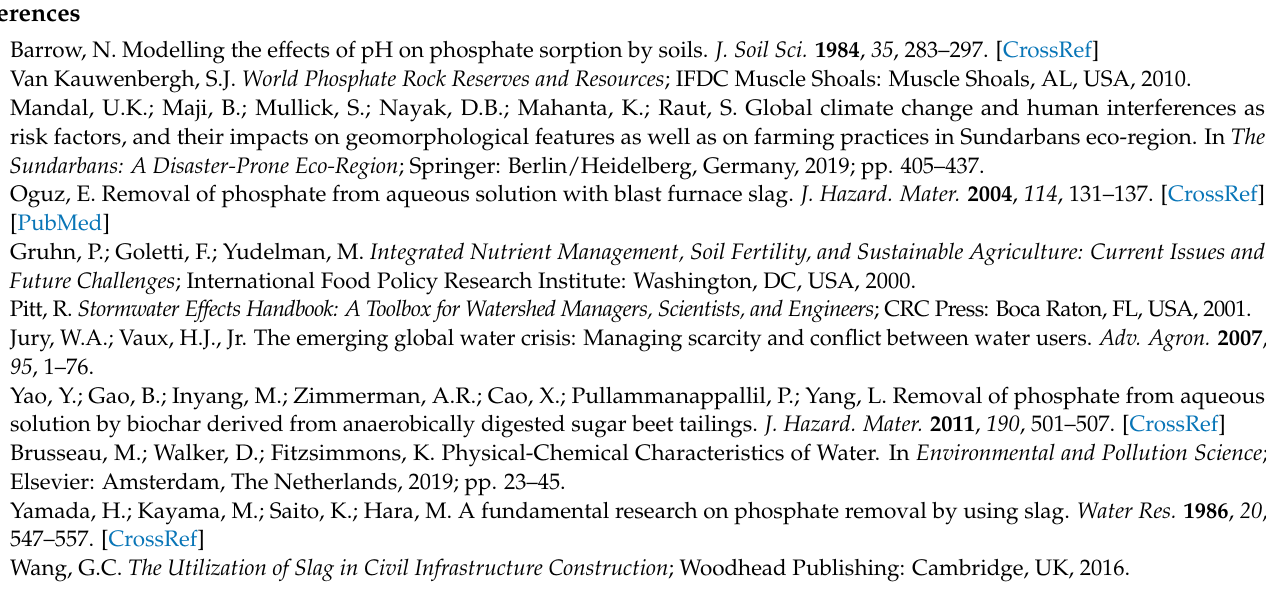
phosphate adsorption; Figure S2: EDX spectra of slag before phosphate adsorption Figure S3: Q vs. Ce for slag over extended initial phosphate concentrations Figure S4: Linearized log( q e − q t ) vs. t , 1st order kinetic plots for AMOB and slag; Table S1: First order kinetic parameters for AMOB and